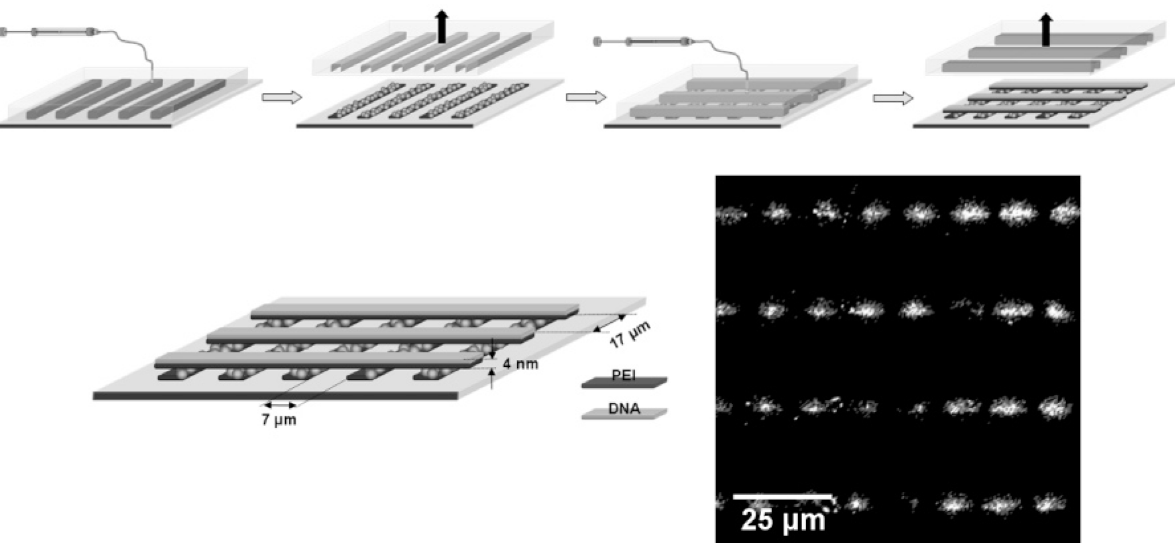
Figure 6. Scheme of the set up used for SERS to characterize the PEM structure formed at the regions where the two perpendicular stripes of polyelectrolytes, PEI and DNA, overlap and form a PEM. The micrograph shows a lateral Raman scan at a fixed wavenumber (757 cm − 1 ), where the PEM regions can be detected with SERS. Reprinted with permission from [49] © 2006 American Chemical